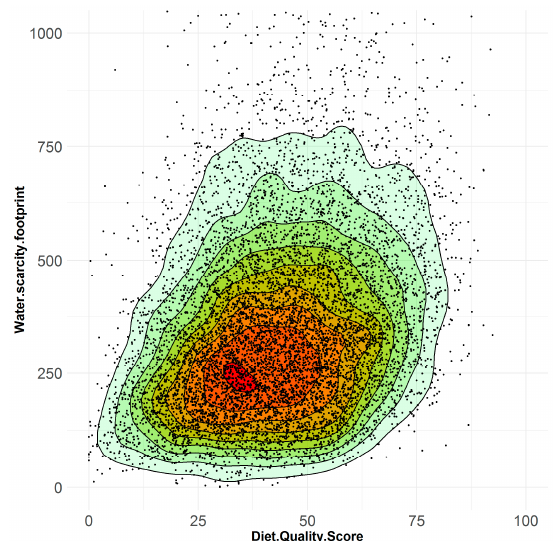
Figure 2. Water-scarcity footprint and diet quality score. Scatterplot showing diversity of individual adult daily diets reported in the Australian Health Survey ( N = 9341). Healthier diets (with higher diet quality score) do not necessarily have a lower water-scarcity footprint (L-eq person − 1 day − 1 ). In Australia, dietary guidelines differ for the different adult life stages (19–50 years, 51–70 years, 71 years and older). For the largest adult subgroup (19–50 years; N = 5157), we compared dietary patterns characterized by higher diet quality and lower water-scarcity footprint (HDQ-LWF) to those characterized by lower diet quality and higher water-scarcity footprint (LDQ-HWF) (see Methods for